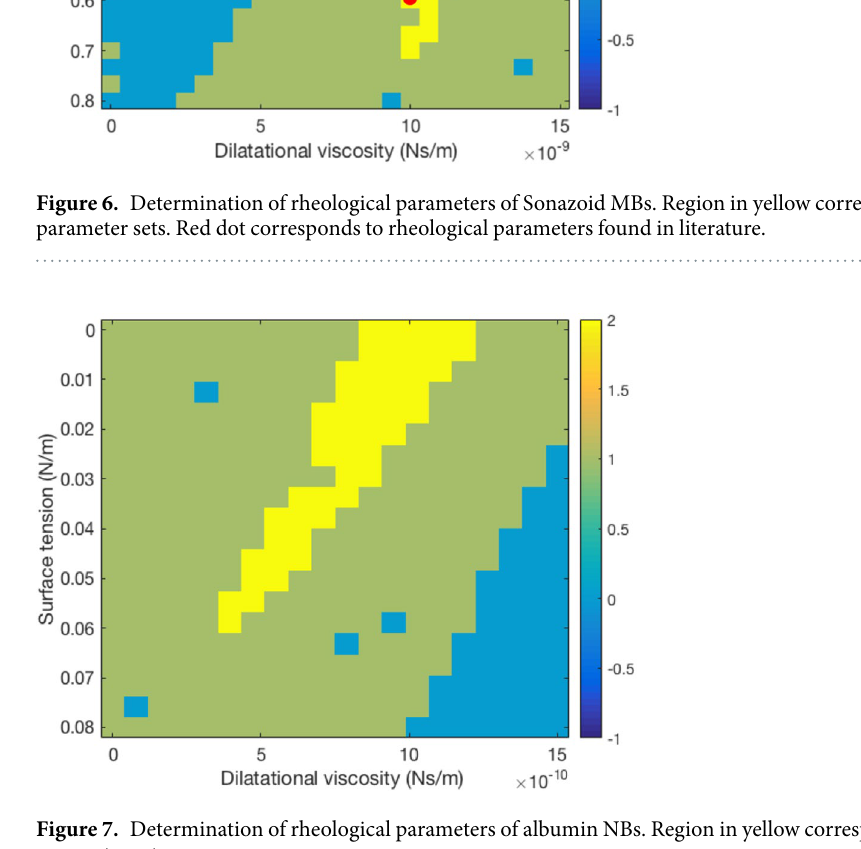
Figure 7. Determination of rheological parameters of albumin NBs. Region in yellow corresponds to plausible parameter